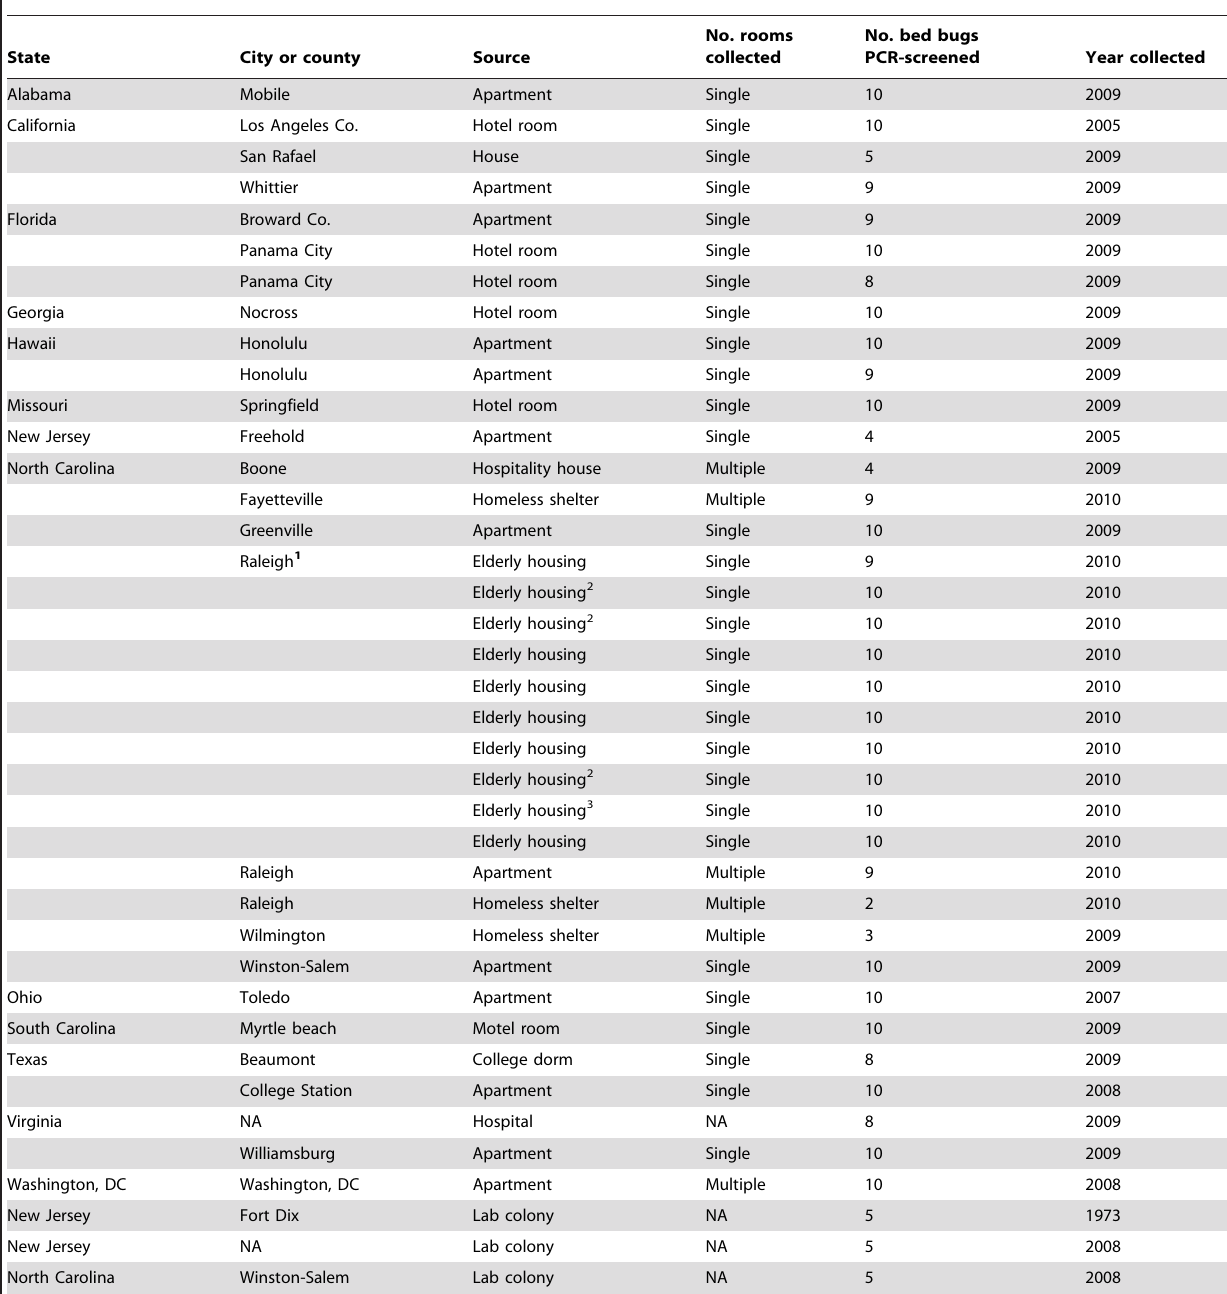
Table 1. Sources of bed bugs screened by PCR for Bartonella